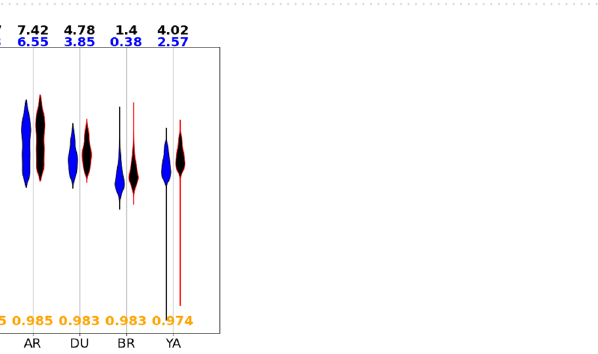
Figure 1. Reproduction of analysis presented in Figs. 2a, 3C, and Q in Holmes et al. 10 . ( a ) Sensible heat ( H ) vs. (cid:31) T = T seq − T a based on the short equation [ T seq , Eq. (10)]; ( b ) H vs. (cid:31) T based on the long equation ( T leq , Eq. 6). Both show data for August 2005 at Brookings. Blue crosses represent data points satisfying the filtering criteria, while black dots represent points not considered in the analysis. N is the number of blue crosses used 2 for regression (red line), m is the slope of regression, RMSE is the root mean square error and R is the square of the coefficient of determination. The fitted ε value is reported in the title. ( c ) Optimised ε values at Brookings 2 > 0.5 obtained for the months where R using the short equation (Eq. 9, black dots) and long equation (Eq. 6, blue stars), and ε obtained using the approach of Maes et al. 11 (red stars). ( d ) Same as ( c ), but for Yatir Forest, see Table 2 for site descriptions.